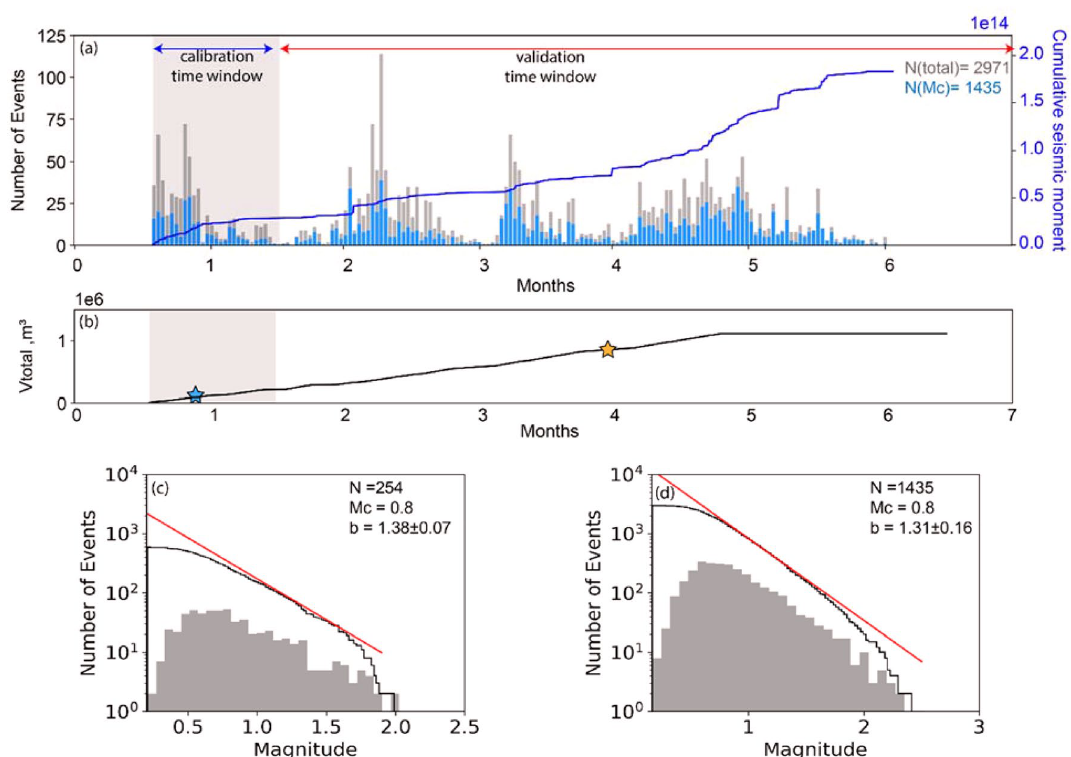
Figure 2. Seismic and injection history of project area one. ( a ) Histogram of the number of detected seismic events per day (grey bars for all observed seismic events and blue bars for those with magnitude larger than M c ), and the cumulative seismic moment (solid blue line) according to injection time. ( b ) The total injection volume versus time. The blue and orange stars show the timing of the maximum moment magnitude event during injection for calibration and validation time window, respectively. The Gutenberg-Richter relation, together with M c and b value for calibration time window and entire dataset are presented in ( c ) and ( d ), respectively. The b value was calculated using the maximum likelihood method 48 , where the uncertainty shows the 95% confidence limits. The magnitude of completeness ( M c ) was calculated using the b -value stability method 49